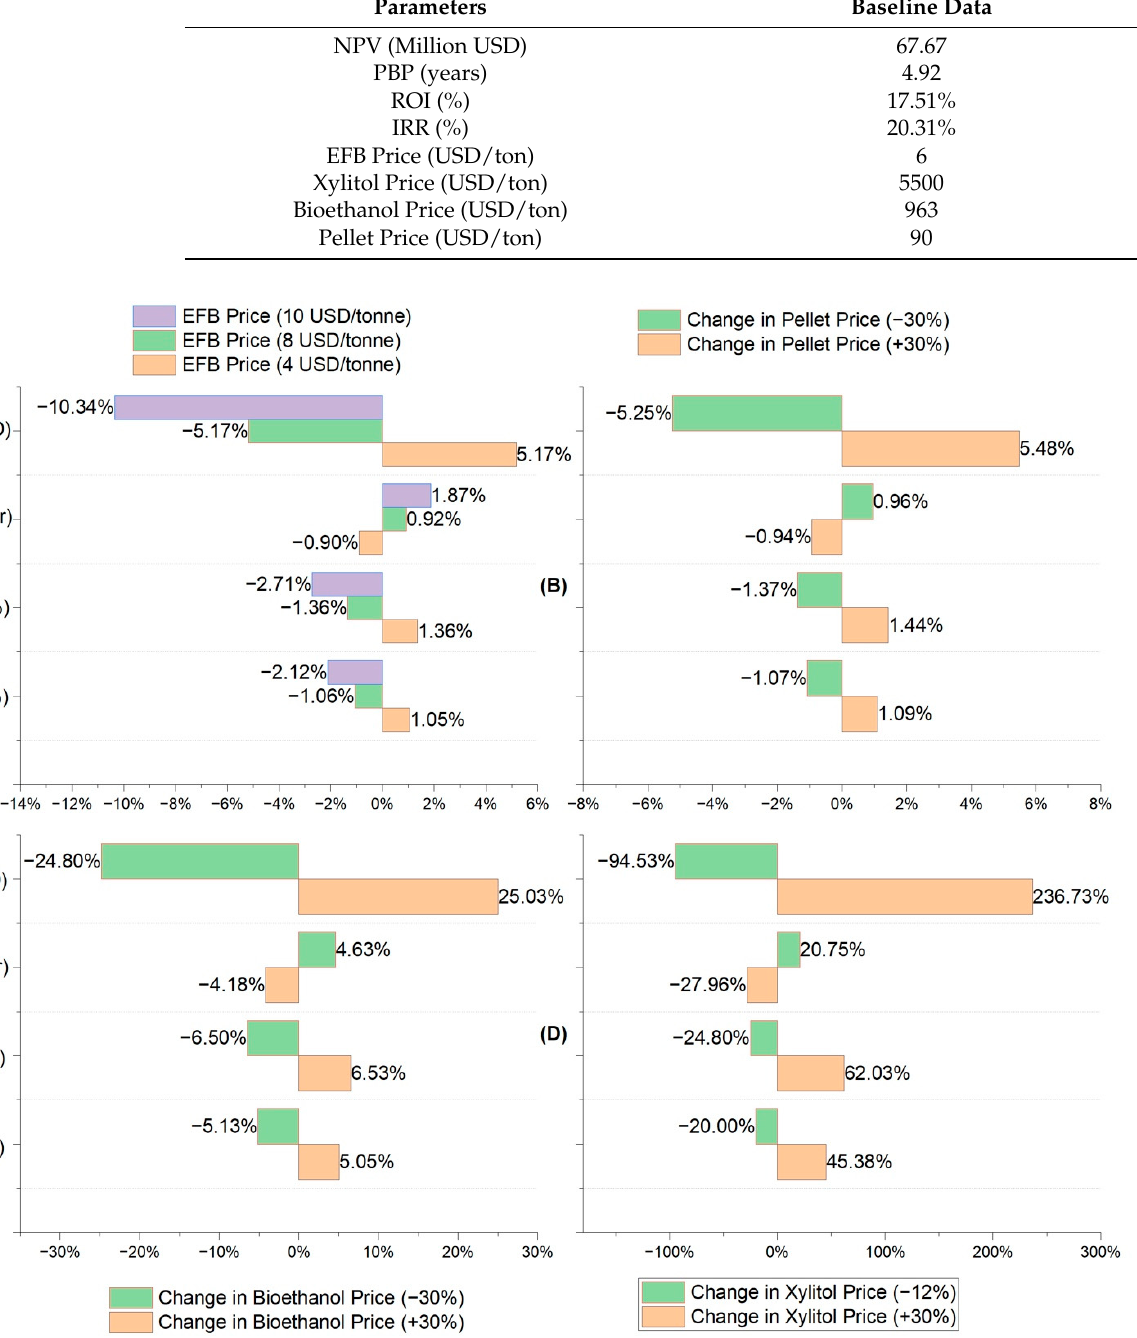
Table 8. Baseline parameters and economic performance metrics at an EFB splitting ratio of 30% to pellet production.